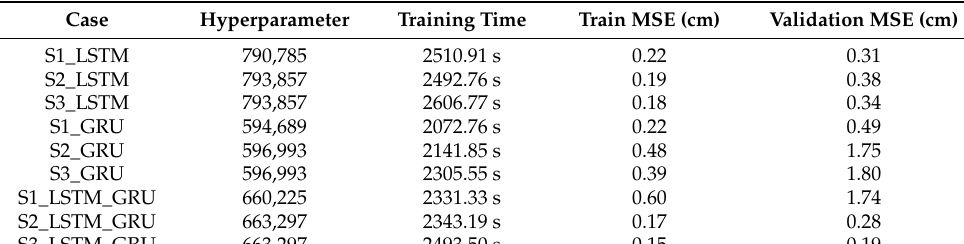
Table 3. Training and validation results.